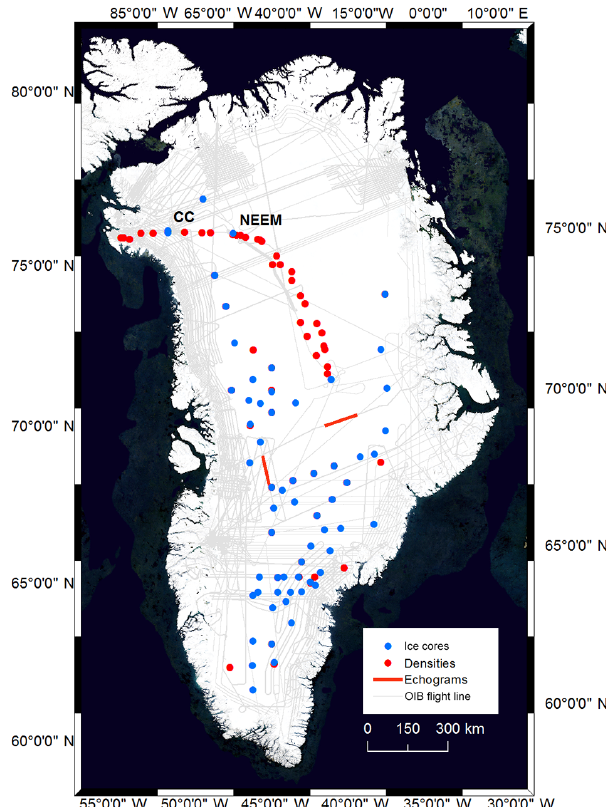
Figure 1. Locations of snow/firn density measurements (red circles) and ice-core accumulation measurements (blue circles) used in this study with OIB flight line coverage from 2009 through 2012 (gray lines). Camp Century (CC) and NEEM core locations are labeled and the red lines indicate the locations of the radargrams in Fig. 3.